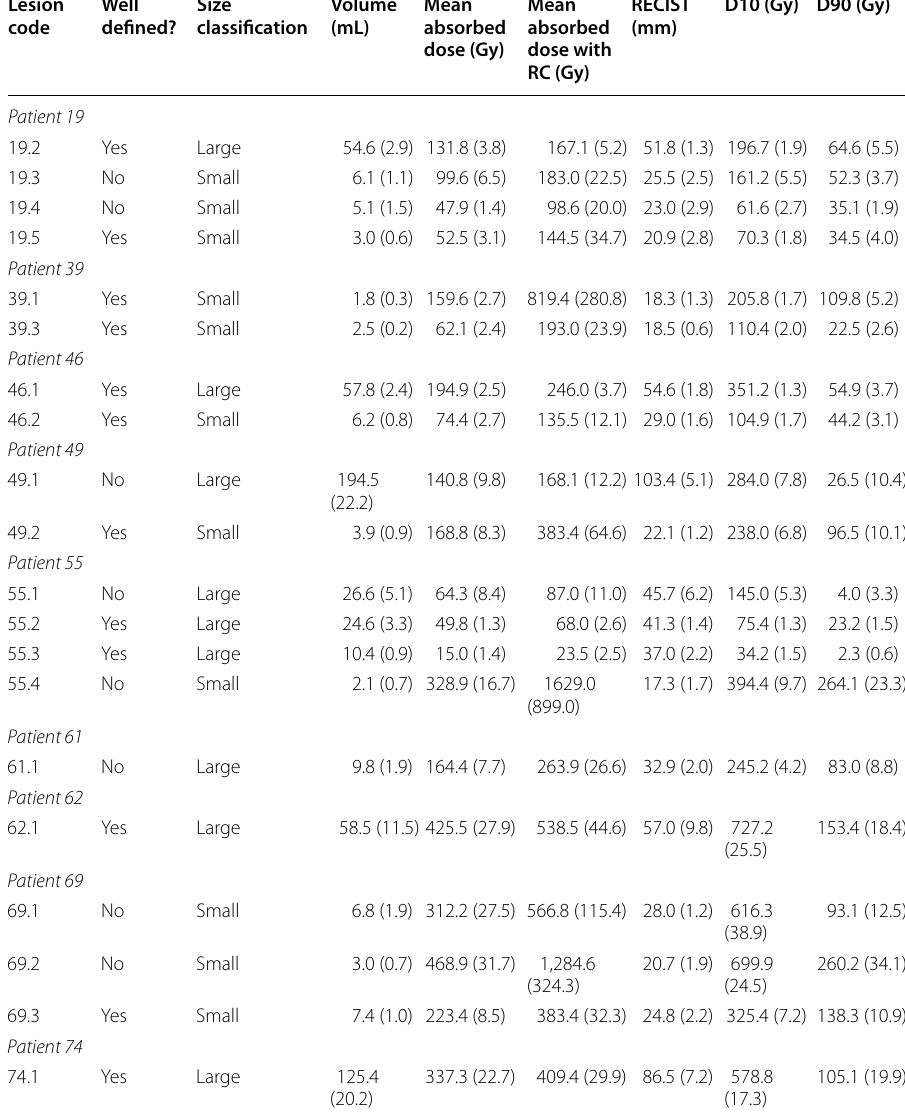
Table 1 Descriptive statistics by lesion, summarized by mean (SD) across the 7 reads Lesion